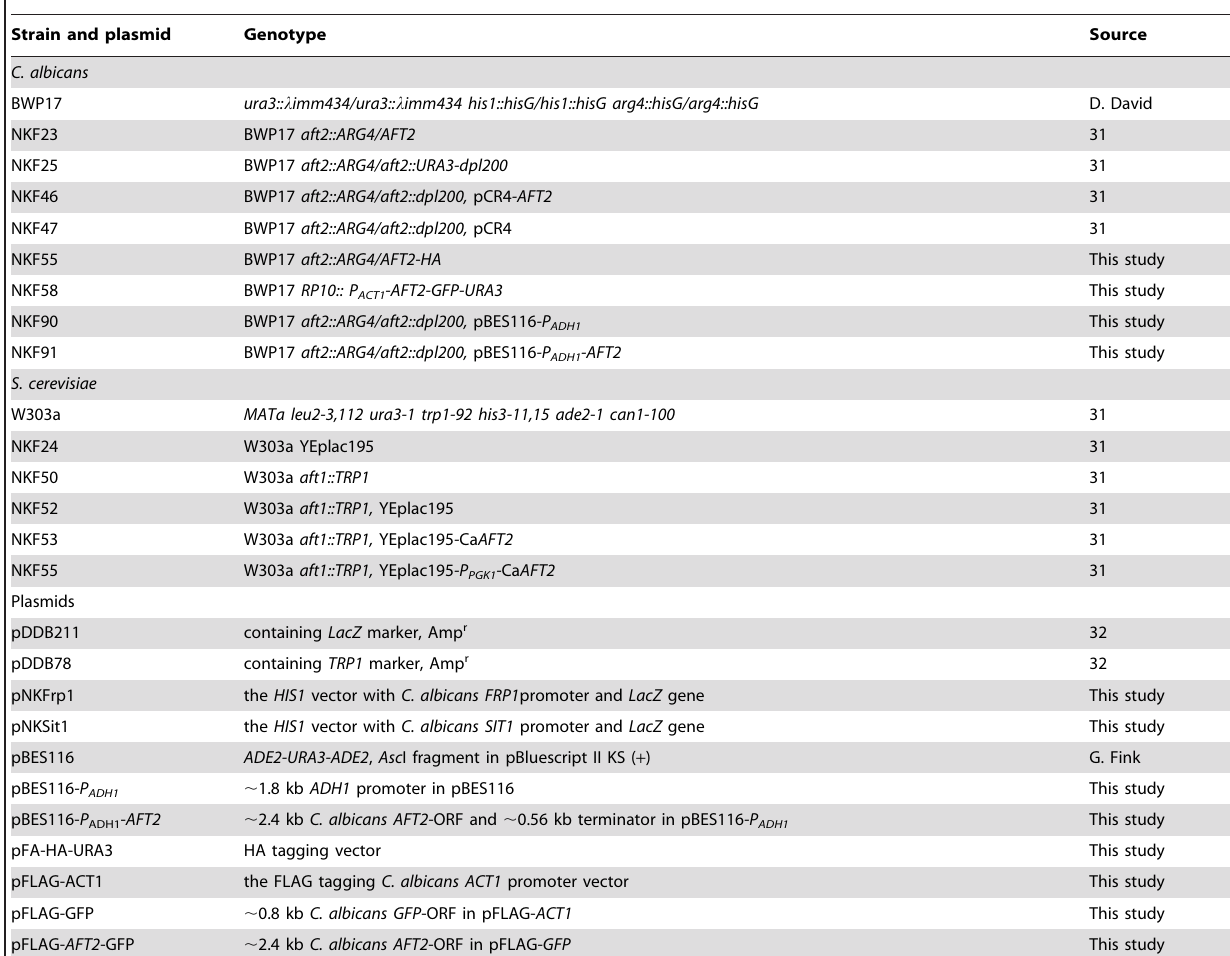
Table 1. Strains and plasmids used in this